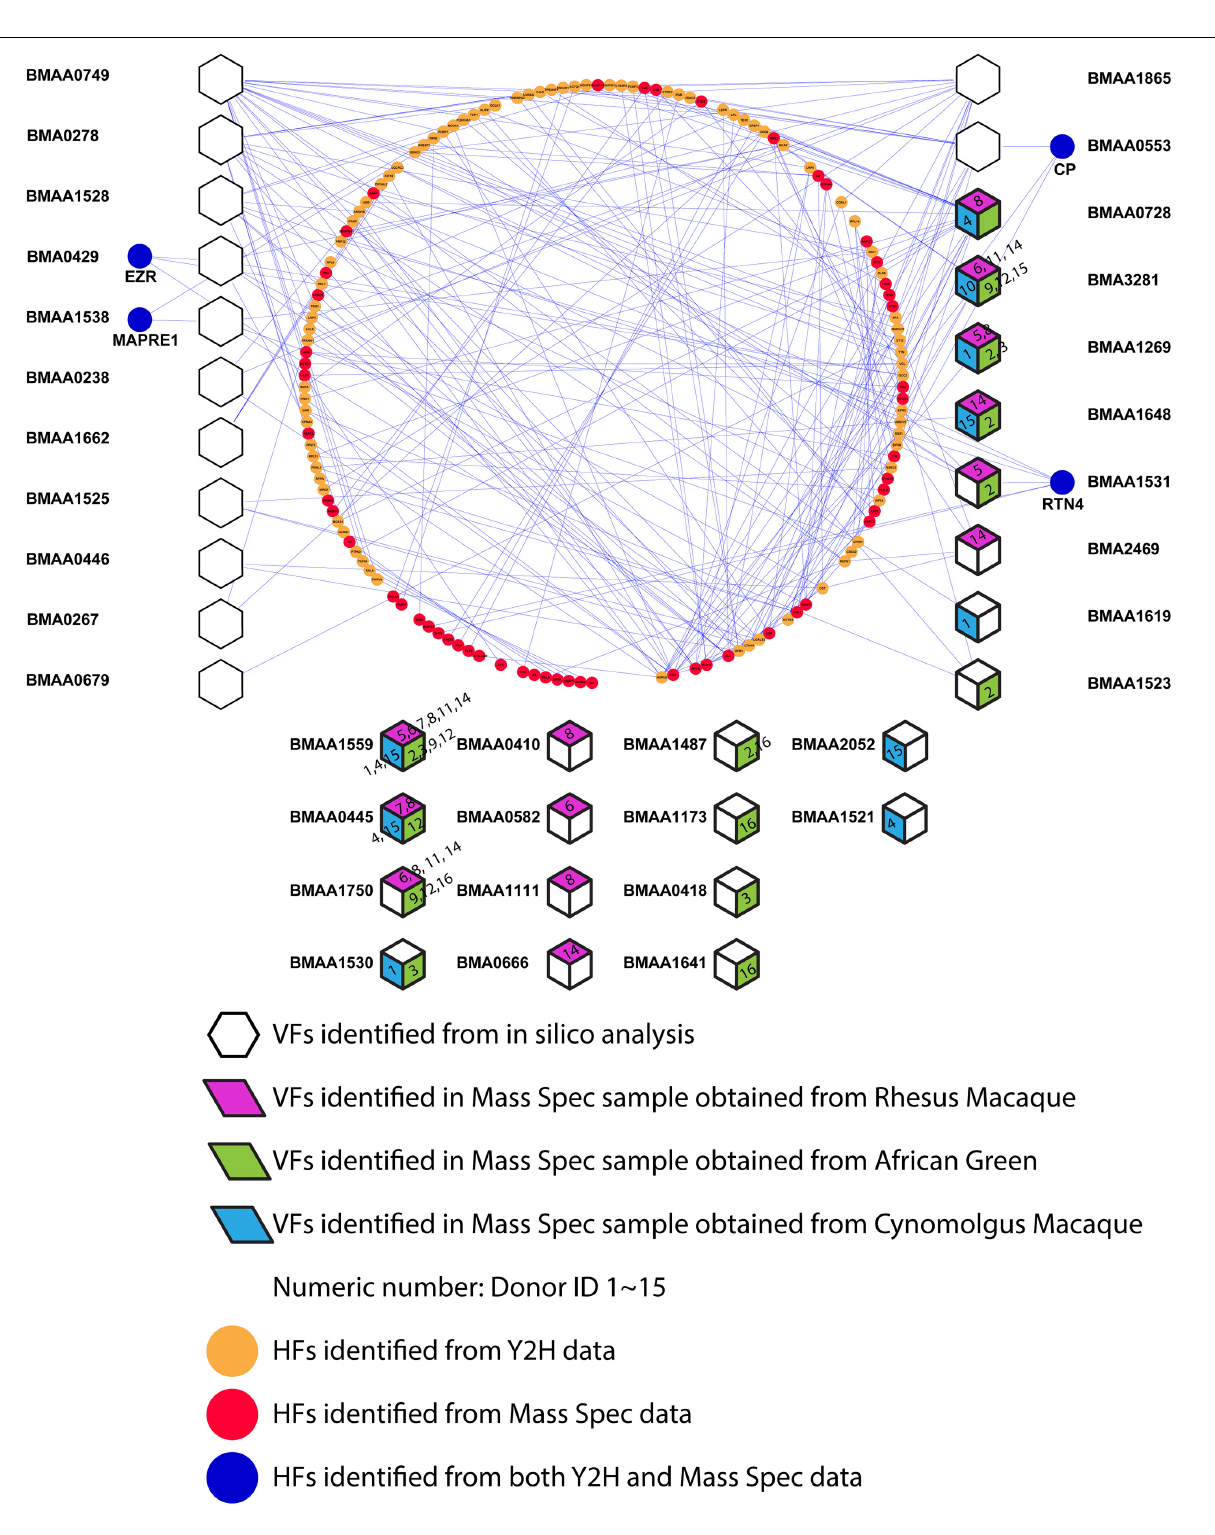
FIGURE 4 | The network relationship between identified host factors and B. mallei virulence factor is depicted. Hexagons indicate B. mallei virulence factors identified by Memiševi´c et al. (2013). Red, green and blue diamonds indicate the presence of B. mallei virulence factor in rhesus macaque, African green monkey and cynomolgus macaque, respectively. Orange and Red nodes depict host factors identified by Memiševi´c et al. (2013) using Y2H method or LC-MS/MS approach, respectively. Blue nodes depict host factors identified by both Y2H and LC-MS/MS approach. The digits on the diamonds represent the identification number of the donor